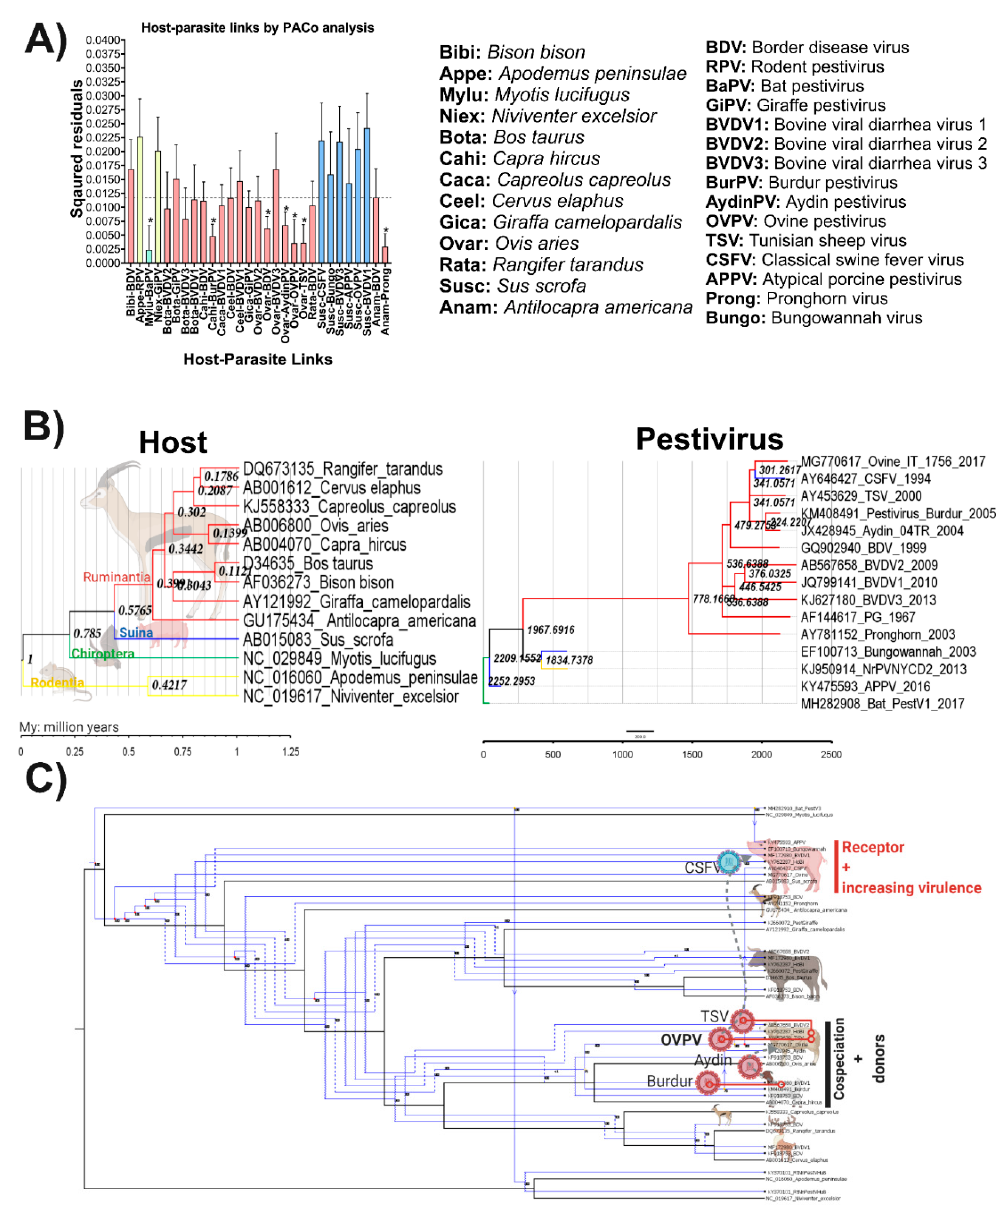
Figure 7. Viral–host coevolutionary history reconstruction for the Pestivirus genus. ( A ) Contributions of individual host–parasite links to the procrustean fit (right)—jacknifed squared residuals (bars) and upper 95% confidence intervals (error bars) resulting from applying PACo to patristic. Links supported among the Pestivirus species and their respective hosts were denoted (*). The median squared residual value obtained is represented by a dashed line. A pattern of color was used to facilitate the identification of the hosts—ruminants are denoted in red, rodents in yellow, bats in green, and swine in blue. Each viral and host specie used in the analysis is denoted in the left. ( B ) Topology comparison between the evolutionary history for the host (right) and the Pestivirus